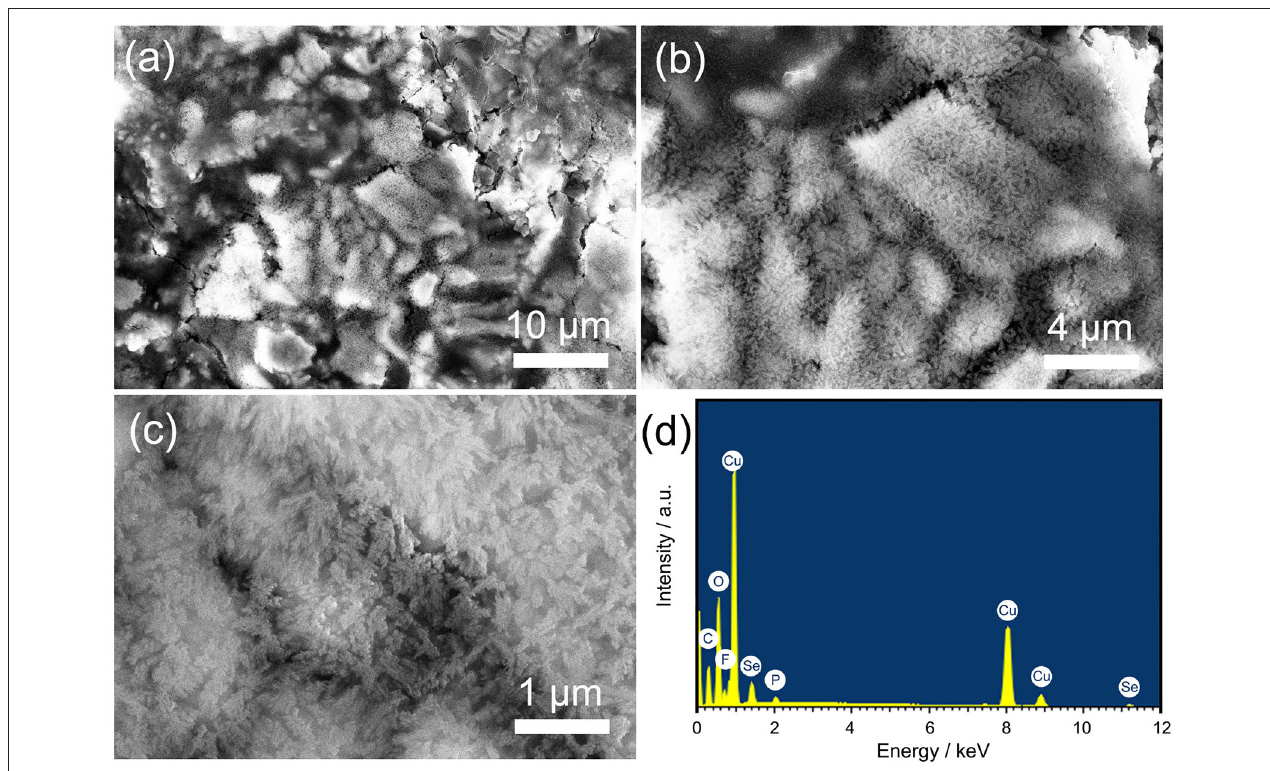
3 CV cycles at different potentials are relatively stable (these resistance values are < 15 ohms), indicating that the